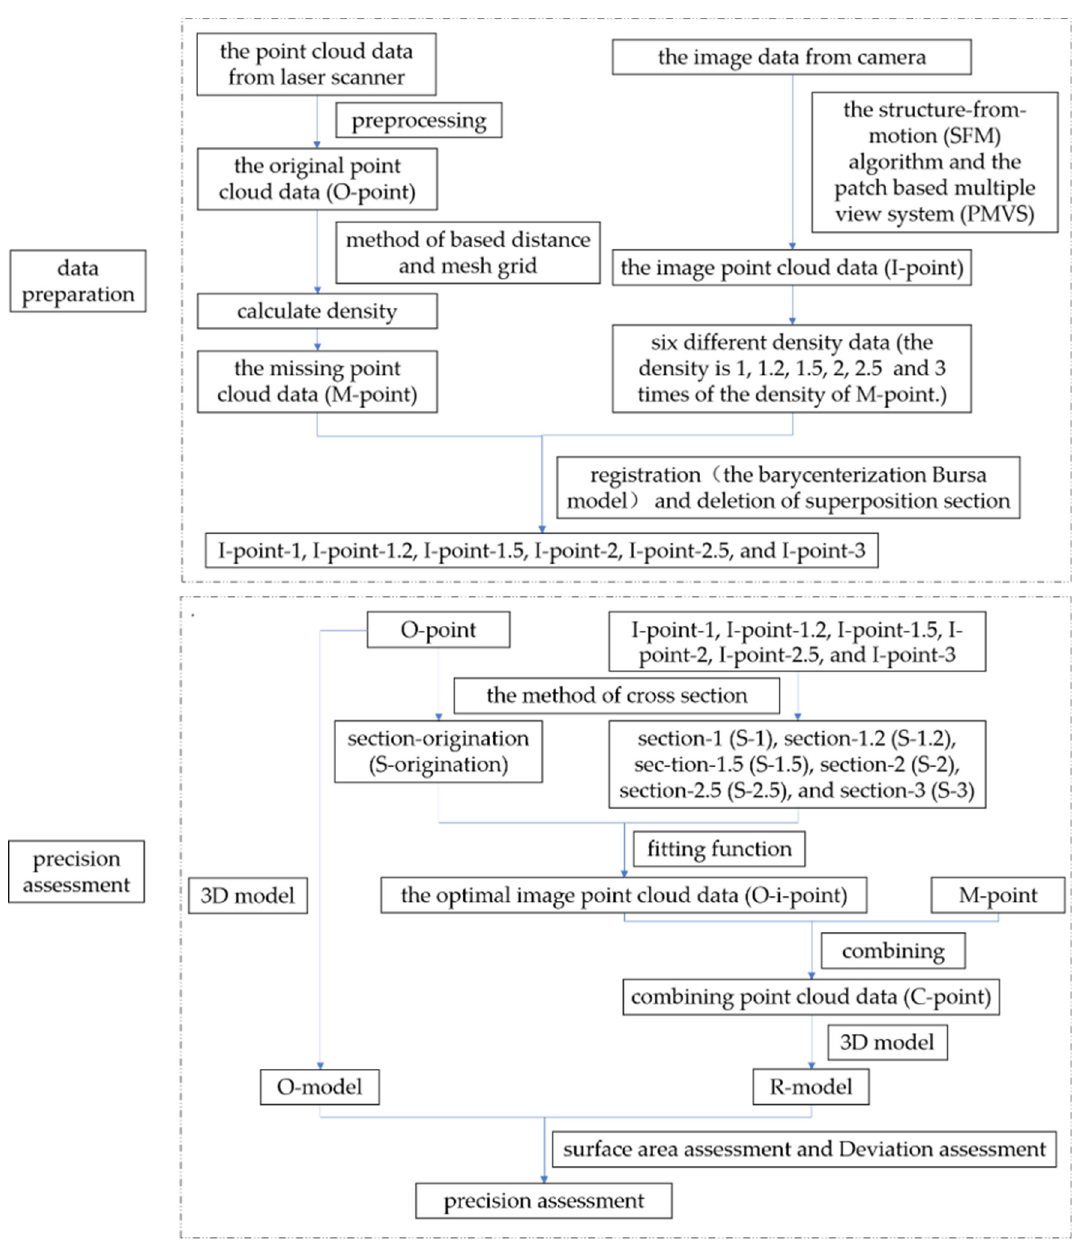
Figure 2. The data processing flow chart.